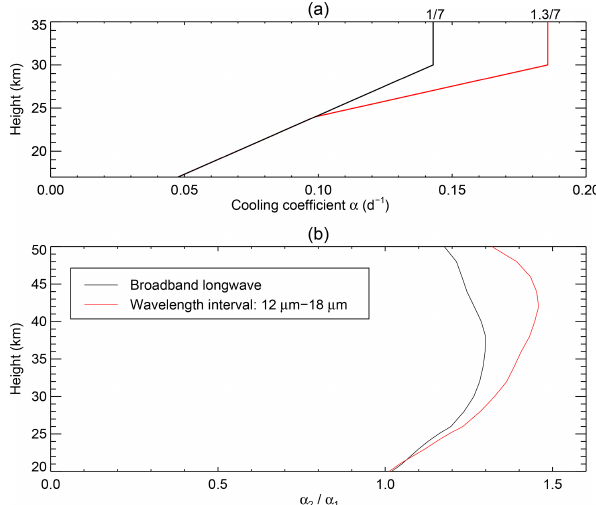
Figure 1. (a) Profiles of Newtonian cooling coefficients: the smaller values (black line) are used for the control runs, while the larger values (red line) are used for the experimental runs. (b) Profiles of the ratio of α 2 to α 1 , where α 1 and α 2 denote the Newtonian cooling coefficient for the reference CO 2 and the doubled CO 2 , respectively. The black line depicts the ratio for the broadband longwave (5– 100µm), and the red line delineates that for the CO 2 absorption band